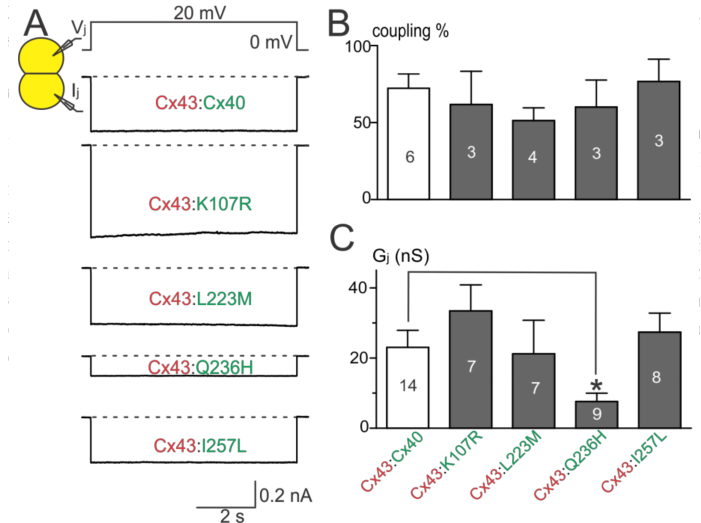
Figure 5. Coupling percentage and G j of co-expressing AF-linked mutants with wildtype Cx43. ( A ) Representative I j s are shown from N2A cell pairs co-expressing Cx40, K107R, L223M, Q236H, or I257L (with an untagged reporter GFP) with wildtype Cx43 (with an untagged reporter DsRed); ( B ) bar graph illustrates coupling percentages of N2A cell pairs expressing each